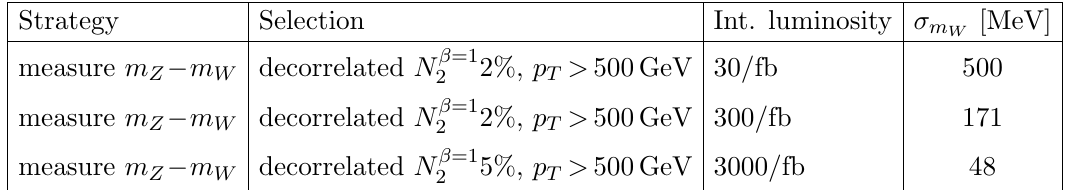
case of the m W mass measurement, because the sample of Z bosons decaying to b quarks is signi(cid:12)cantly smaller than that of W bosons decaying to quarks. We have considered double b -tagger selections corresponding to 10, 30, 45, 75, and 85% Z ! b (cid:22) b jet e(cid:14)ciency to divide up the data into Z ! b (cid:22) b -enriched and the W ! q (cid:22) q -enriched categories. We report the result for the selection corresponding to 45% Z ! b (cid:22) b jet e(cid:14)ciency that yields the best statistical precision for the m Z (cid:0) m W mass measurement. However, it should be noted that yet better precision may be achievable by splitting the sample further into a single- b -enriched and double- b -enriched and light quark enriched samples. Correlating or not correlating the background shape parameters between the two categories does not change the resulting statistical uncertainty on the m Z (cid:0) m W mass measurement, which indicates that the measurement uncertainty is mainly driven by the W and Z peak modeling rather than modeling of the smoothly falling background shape.